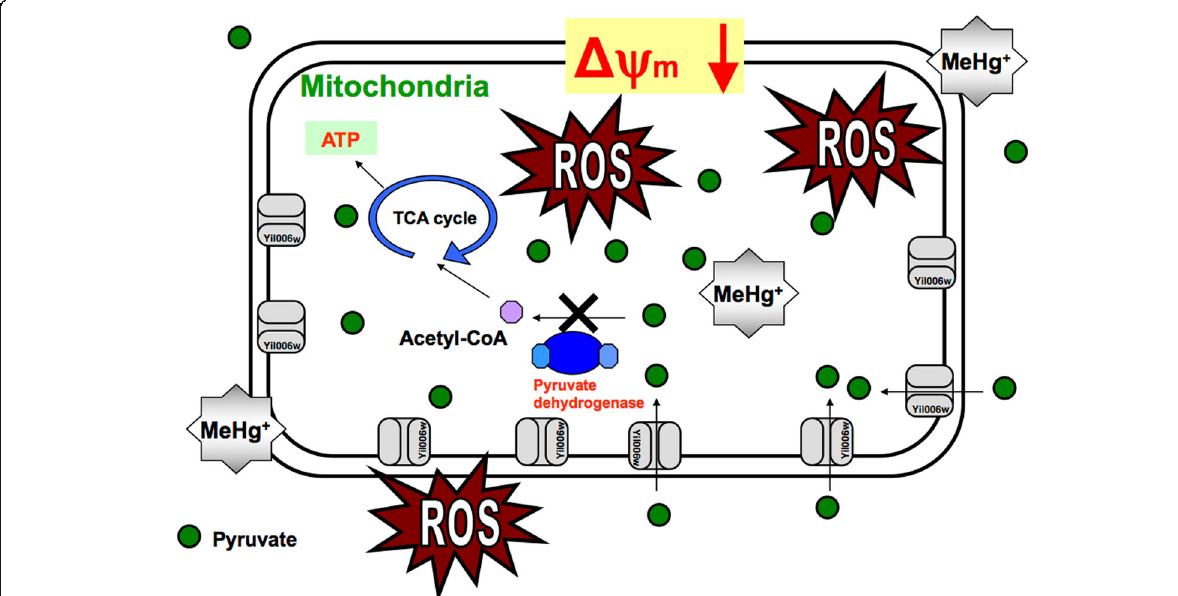
Fig. 2 The scheme of methylmercury toxic mechanism by the pyruvate transportation into mitochondria. MeHg + , methylmercury; Δ Ψ m, mitochondrial membrane potential; ROS, reactive oxygen